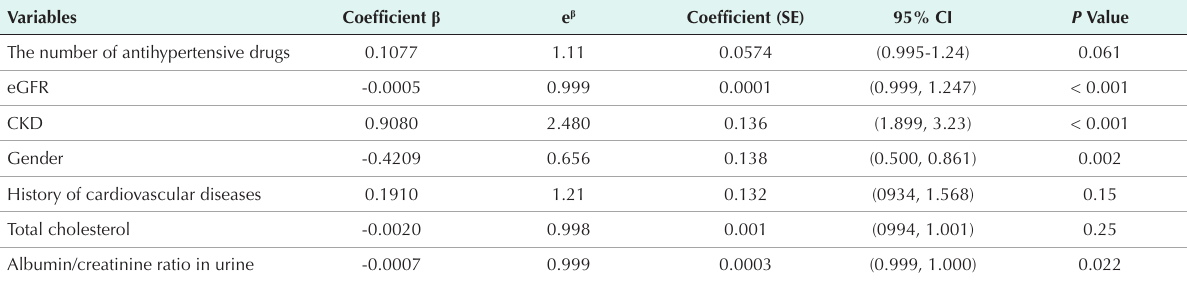
Table 2. The Outcomes of Fitting the Competing Risks Model to the Data of the Patients With HBP Variables Coefficient β The number of antihypertensive